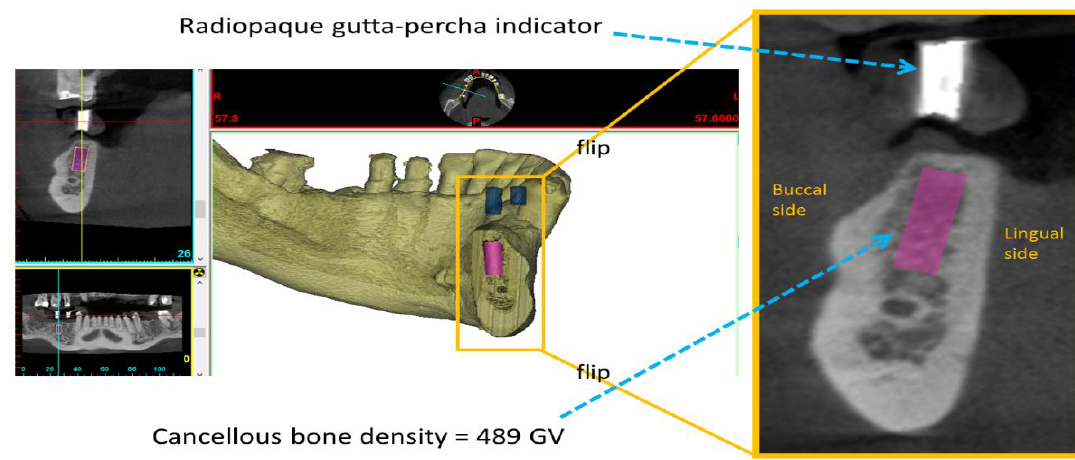
Figure 1. Measurement of cancellous bone density, quantified as the mean grayscale values (GVs) of the cylinder, at a dental implant site.